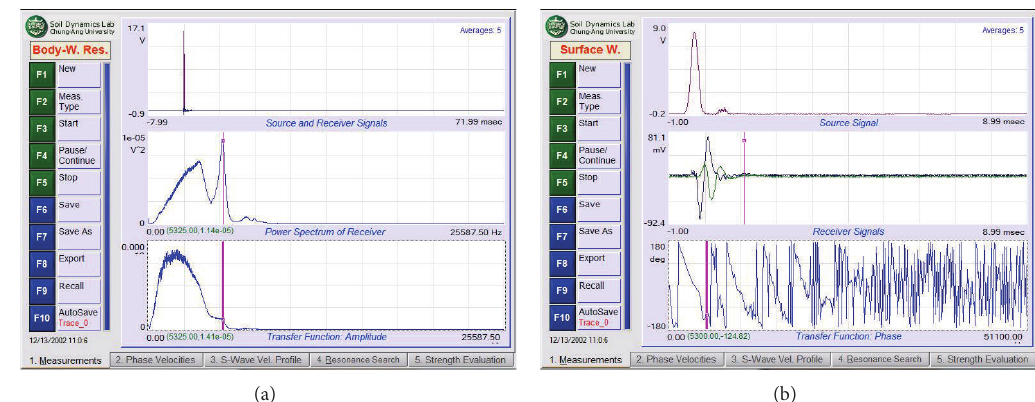
Figure 5: (a) Frequency spectrum of body wave resonance measurement and (b) Phase angle spectrum from surface wave